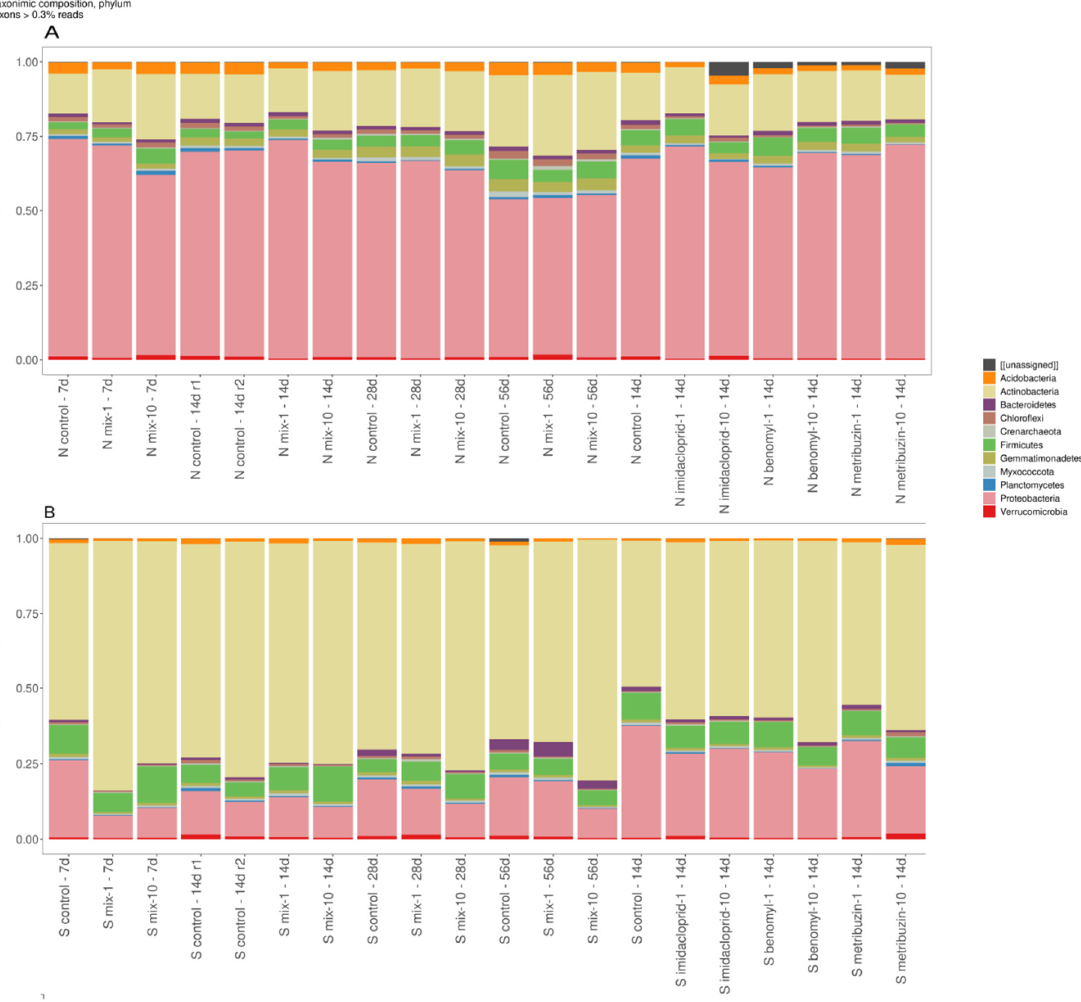
Figure 1. Bacteria’s phyla in all variants of the experiment without SMM ( A ) and with SMM ( B ). After the application of SMM, the representation of Actinobacteria sharply increased while the representation of Proteobacteria decreased (Figure 1).